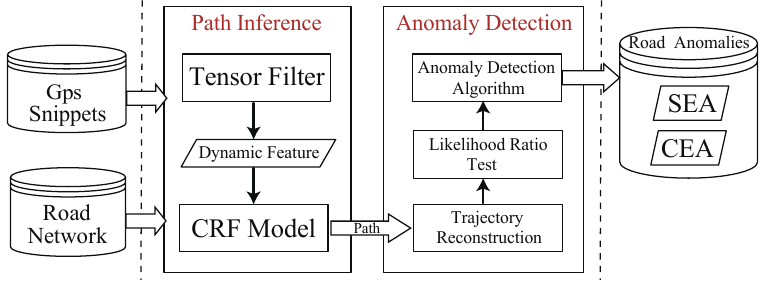
Figure 4. Overview of our